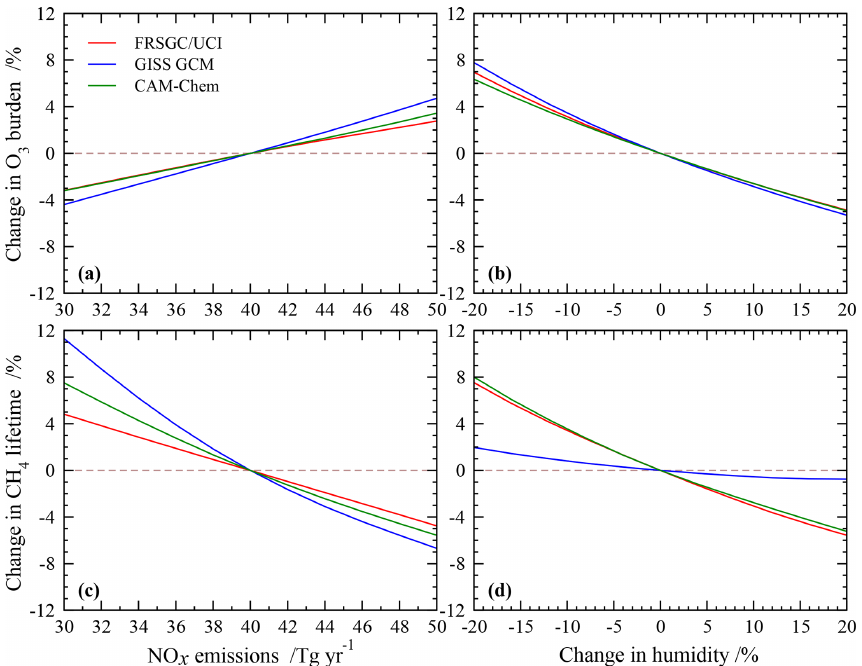
Figure 6. Relative changes in tropospheric O 3 burden (a, b) and CH 4 chemical lifetime (c, d) to changes in surface NO x emissions and humidity alone in each